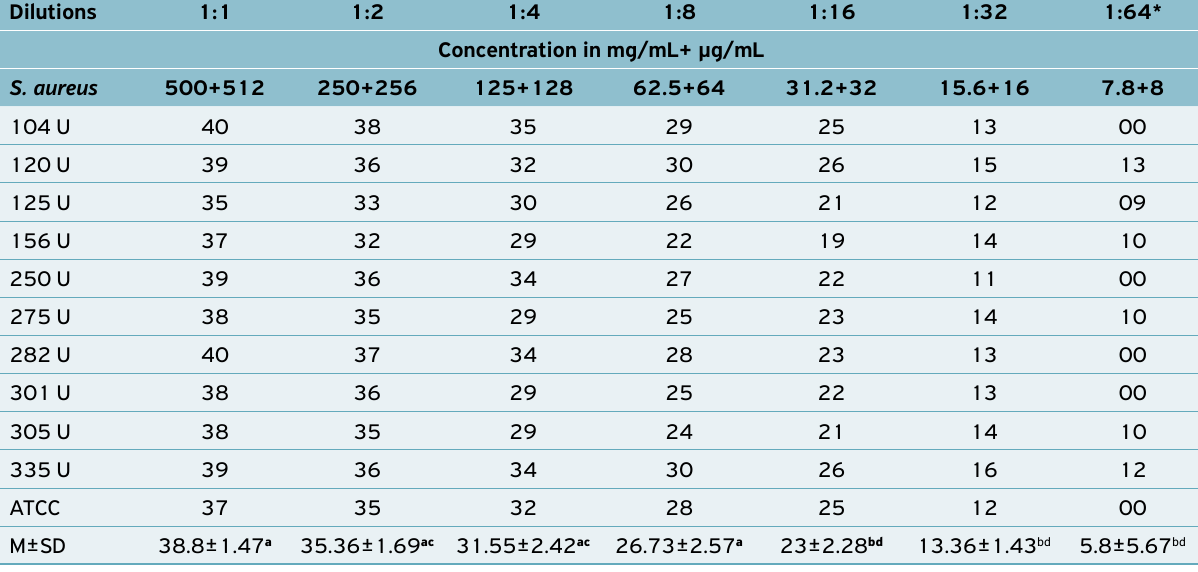
Table 2. Mean ± standard deviation of the minimum inhibitory concentration (MIC); with diameters of inhibition halos in millimeters (mm), on solid medium; association of Cephalexin with Anadenanthera colubrina extract against Staphylococcus